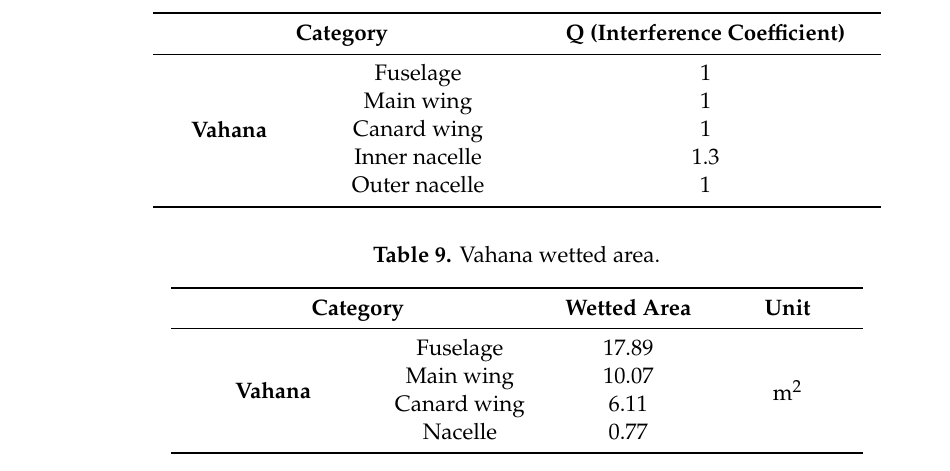
Table 8. Interference coe ffi cient of Vahana.